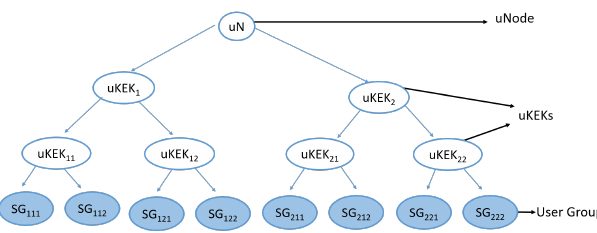
Figure 5. The LKH tree structure of four devices in a DG (left) and five users in a SG (right).